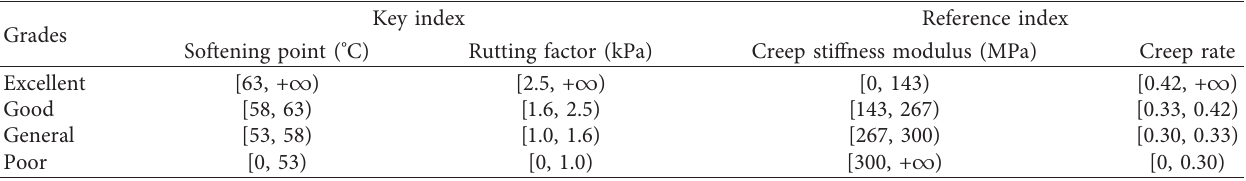
Table 1: Classification standard of high modulus asphalt.